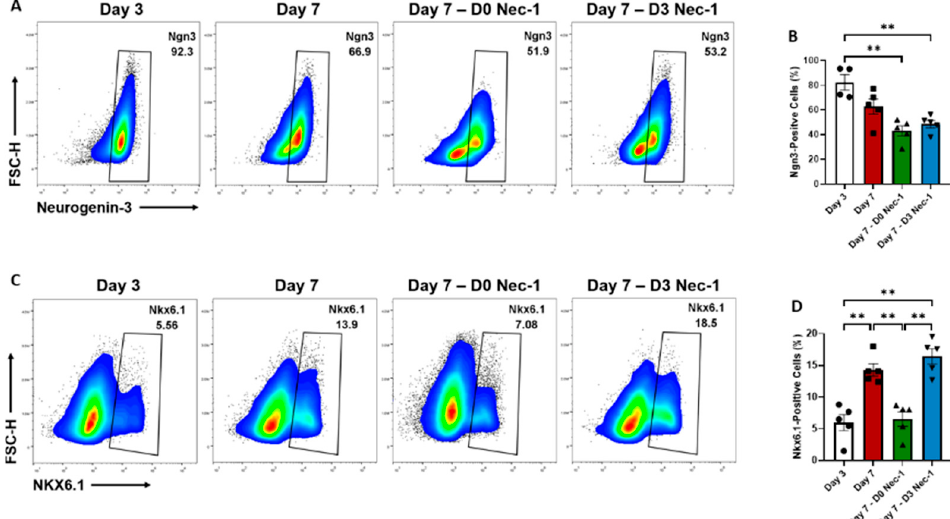
Figure 3. Flow cytometric analysis of endocrine cellular differentiation of PPIs on day 3 and 7 of tissue culture in control media or media supplemented with Nec-1 either immediately after islet isolation (D0 Nec-1) or on day 3 of tissue culture (D3 Nec-1). Islets were dissociated on day 3 and 7 of tissue culture using Accutase, stained with 7-AAD viability dye, anti-Ngn3, and anti-Nkx6.1 antibodies, and analyzed by flow cytometry. ( A ) Representative flow cytometry plots of neurogenin-3 staining of live islet cells on day 3 and 7 of tissue culture. ( B ) The percentage of Ngn3-positive cells on day 3 and 7 of tissue culture. ( C ) Representative flow cytometry plots of Nkx6.1 staining of live islet cells on day 3 and 7 of tissue culture. ( D ) The percentage of Nkx6.1-positive cells on day 3 and 7 of tissue culture. n = 5 for each group. ** p < 0.01. Individual data points for islets cultured in control media on day 3 (Day 3) or day 7 of tissue culture (Day 7) or in media supplemented with Nec-1 either immediately after islet isolation (D0 Nec-1) or on day 3 of tissue culture (D3 Nec-1) are shown within each bar graph as either circles, squares, triangles, or inverted triangles, respectively. Data expressed as mean ± SEM.